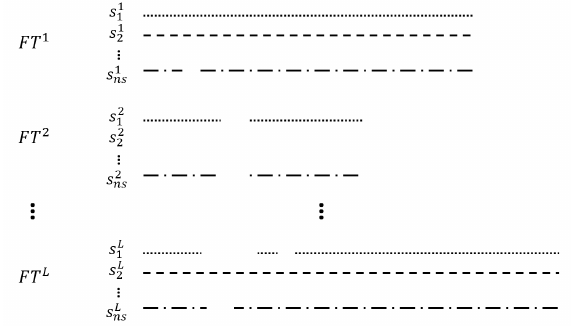
Figure 5. Examples of the missile